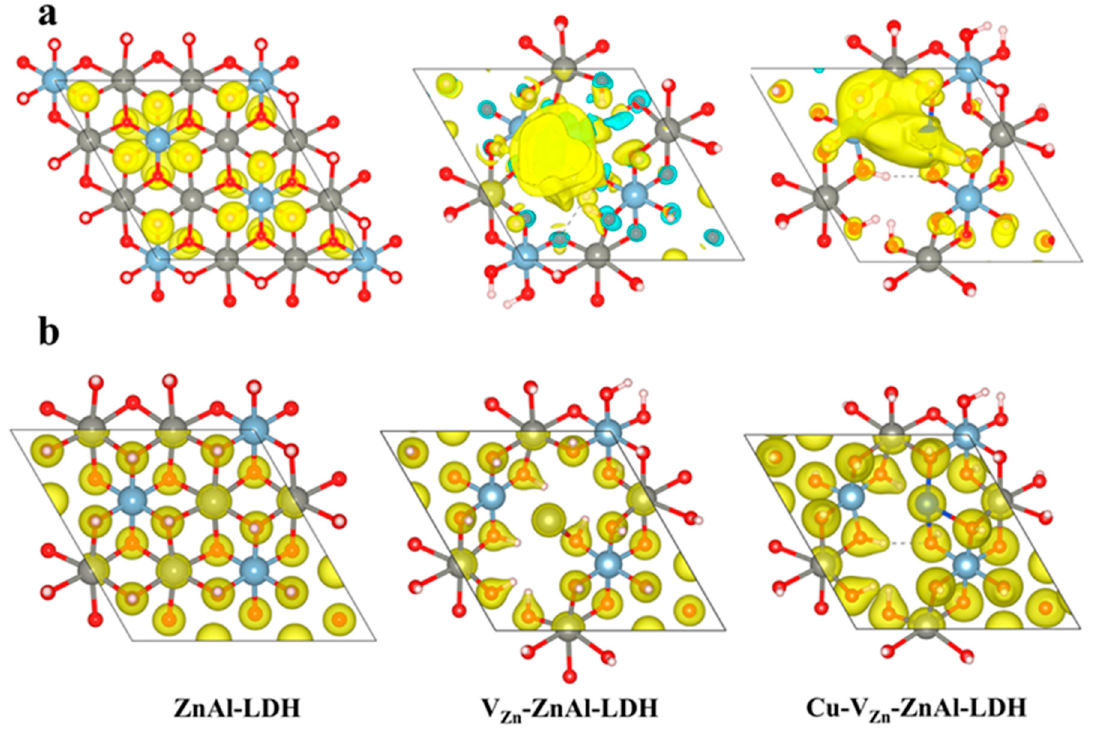
Figure 3. ( a ) The spin density and ( b ) the charge density of three